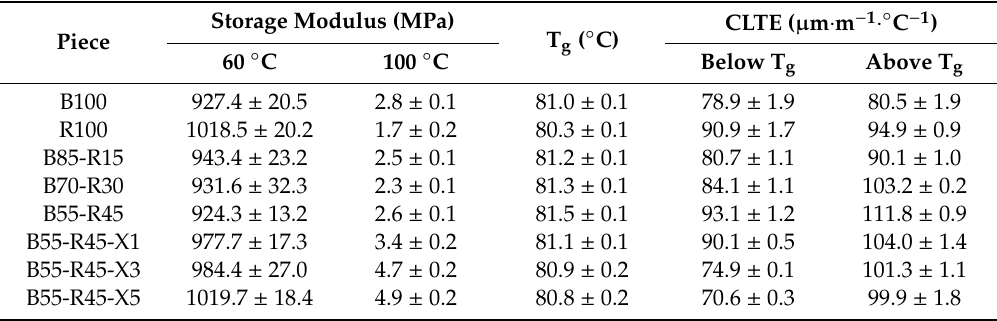
Table6. Storagemodulusmeasuredat60 ◦ Cand100 ◦ C,glasstransitiontemperature(T g ), andcoe ffi cient of linear thermal expansion (CLTE) of the injection-molded pieces of the partially bio-based and recycled polyethylene terephthalate (bio-PET / r-PET)